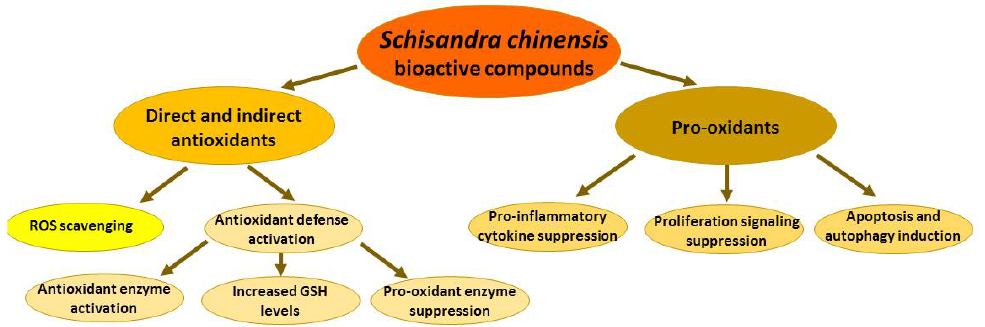
Figure 3. Antioxidant and pro-oxidant activities of Schisandra chinensis fruit extracts and their bioactive compounds. ROS—reactive oxygen species.